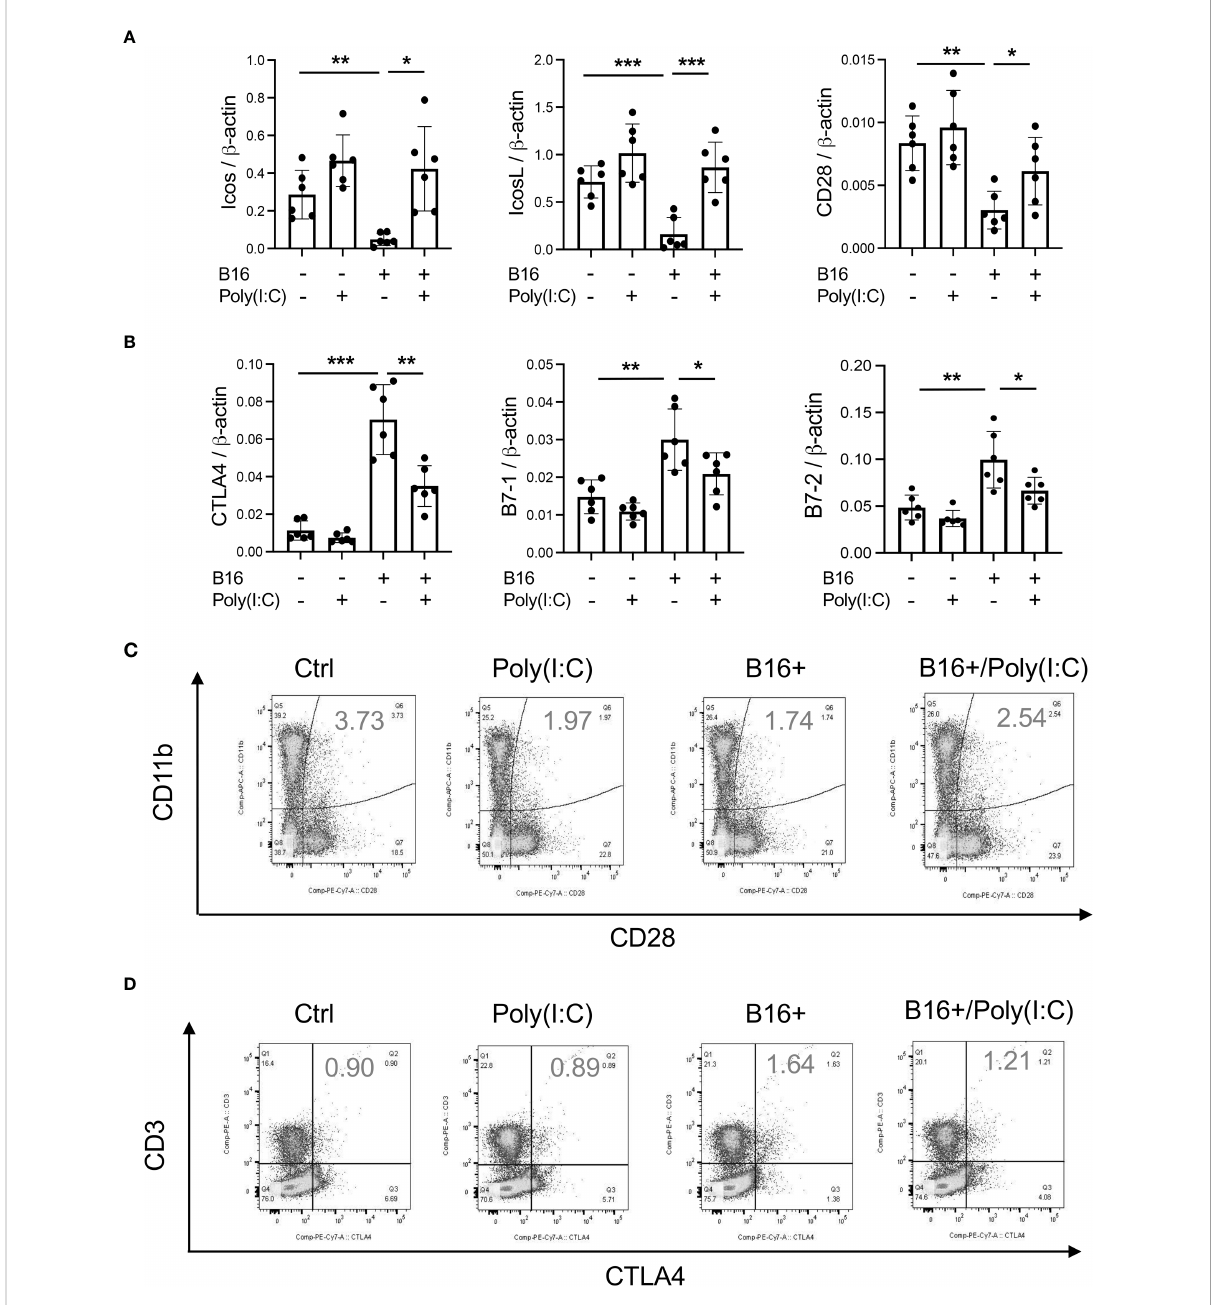
FIGURE 5 Rig-like helicase (RLH) activation augments co-stimulation and inhibits CTLA-4, B7-1 and B7-2. WT mice were used to evaluate the effects of Rig- like helicase activation with Poly (I:C) on co-stimulation and the CTLA-4 axis. (A) RT-PCR was used to quantitate the levels of mRNA encoding ICOS, ICOS L and CD28 in the lungs from WT mice that received B16 cells (B16+) or vehicle control (B16-) and were treated with Poly (I:C) (+) or its vehicle control (Poly(I:C)-). (B) RT-PCR was used to quantitate the levels of mRNA encoding CTLA-4, B7-1 and B7-2 in the lungs from WT mice that received B16 cells (B16+) or vehicle control (B16-) and were treated with Poly (I:C) (+) or its vehicle control (Poly(I:C)-). (C) FACS evaluations comparing the expression of CTLA-4 on CD3+ cells from WT mice that received B16 cells (B16+) or vehicle control (B16-) and were treated with Poly (I:C) or its vehicle control. (D) FACS evaluations comparing the expression of CD28 on CD11b+ cells from WT mice that received B16 cells (B16 +) or vehicle control (B16-) and were treated with Poly (I:C) or its vehicle control. The plotted values in panels (A, B) represent the mean ± SEM of the noted evaluations represented by the individual dots. Panels C and D are representative of a minimum of 2 similar evaluations. * P < 0.05, ** P < 0.01, *** P < 0.001 (ANOVA with multiple